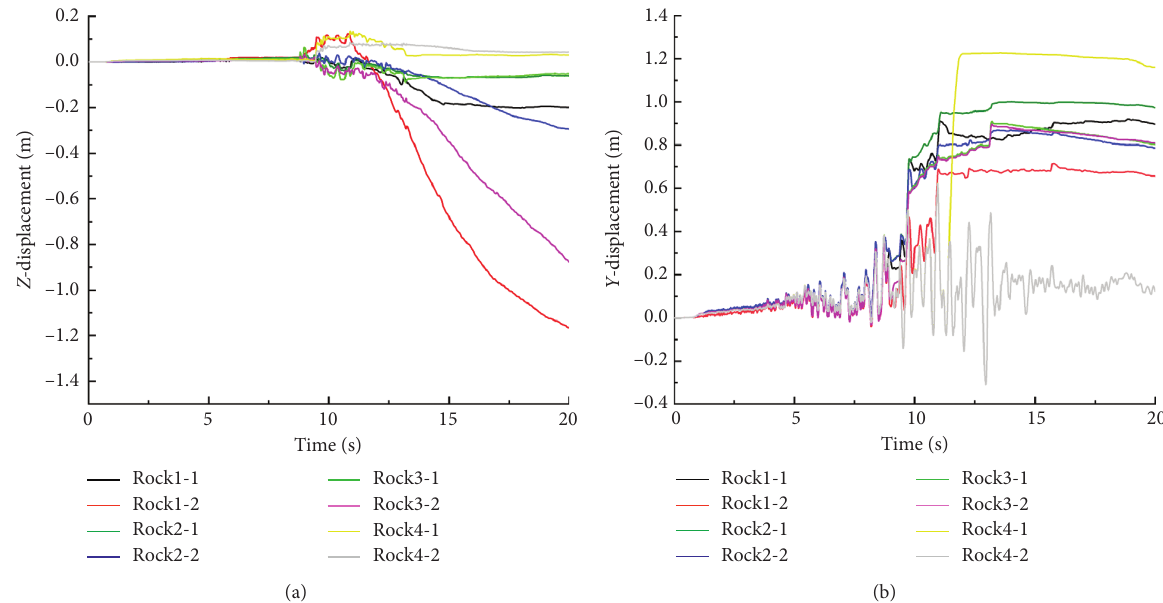
Figure 20: Time history curve of model displacement. (a) Vertical z -direction displacement. (b) Horizontal y -direction displacement.